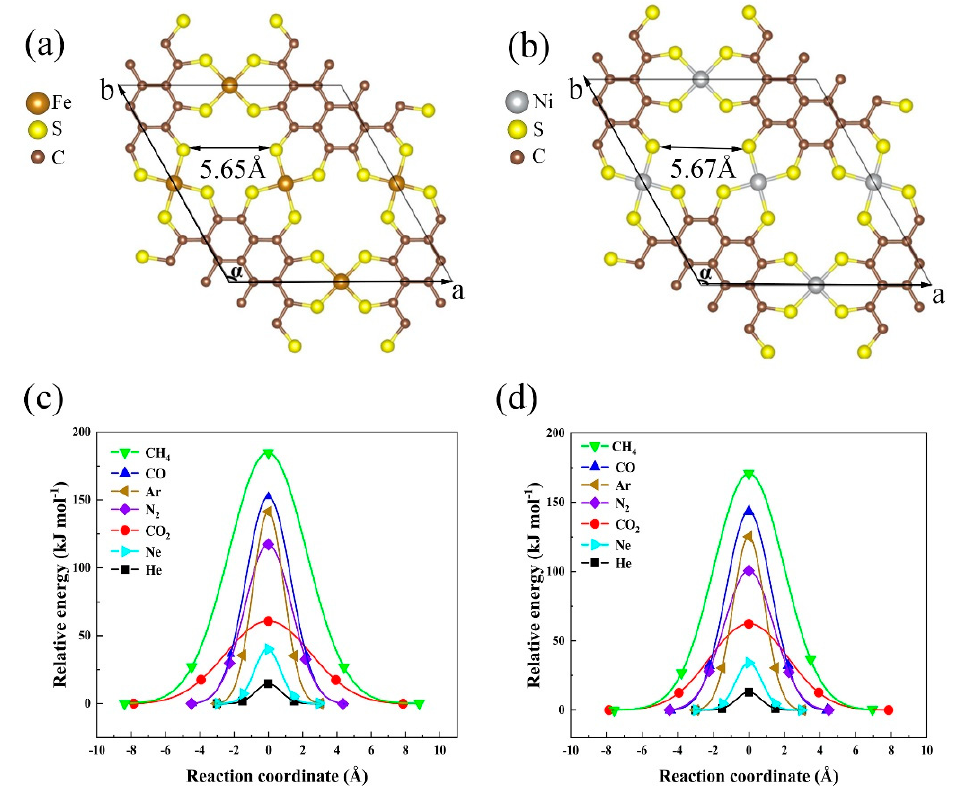
Figure 1. The top views of the optimized unit cell of the ( a ) Fe-PTC and ( b ) Ni-PTC monolayer, where → → a and b represent the cell vectors and α represents the angle between them. The energy profiles for seven prototype gas molecules translocating the ( c ) Fe-PTC and ( d ) Ni-PTC membranes.